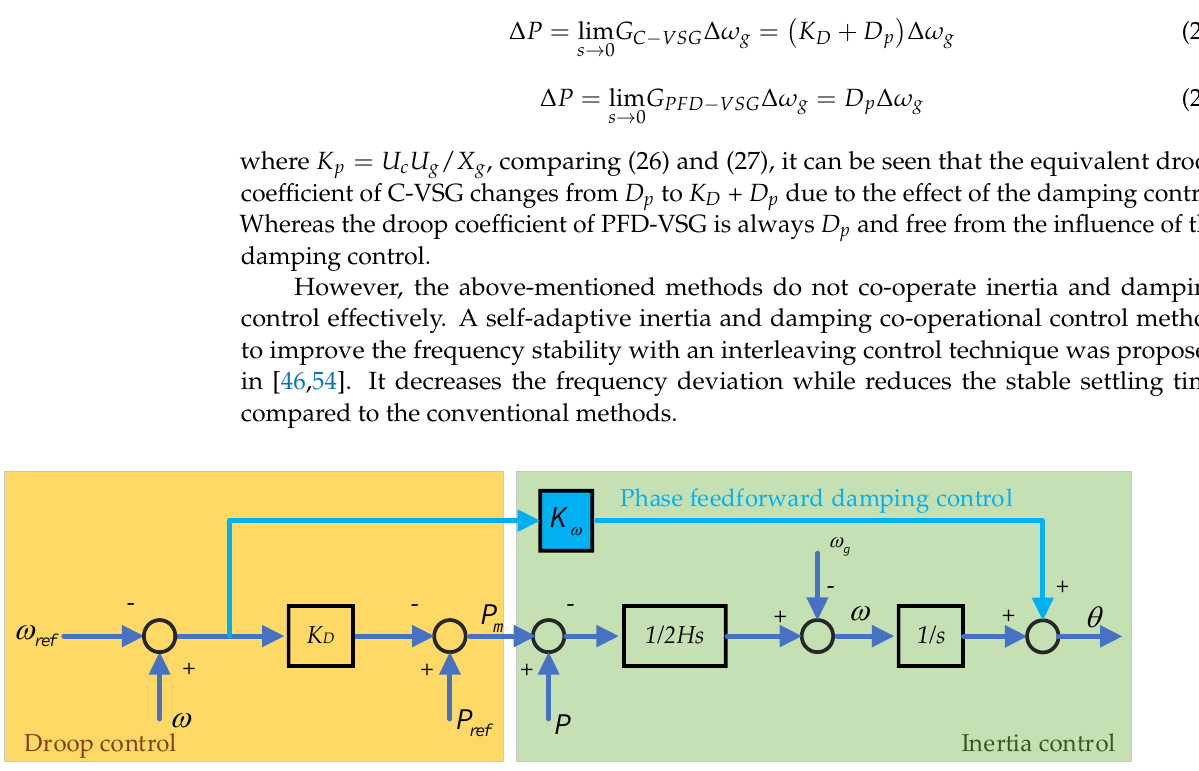
16 of 30 Figure 10 . ( a ) feedback modes of the power-angle control of the VSG; ( b ) Block diagram of mode- adaptive control of the VSG The power change rate is further taken into account to change the moment of inertia so as to limit the frequency change rate [50]. Since the ROCOF is mainly related to the output power and inertia, the output power deviation is used to change the moment of virtual inertia. The larger the power deviation, the larger moment of virtual inertia is used. The output frequency change rate is therefore limited. The control block diagram is shown in Figure 11. Where k  is the adaptive inertia coefficient, D p is the damping coefficient. The active power transfer function is second order due to the existence of an inertia loop, whose dynamic performance is less smooth than first order one. In [51], proportional power feedforward control is used, which adds a zero in the transfer function to cancel one pole in the active power loop. The order of the active power control loop is therefore reduced from two to one.